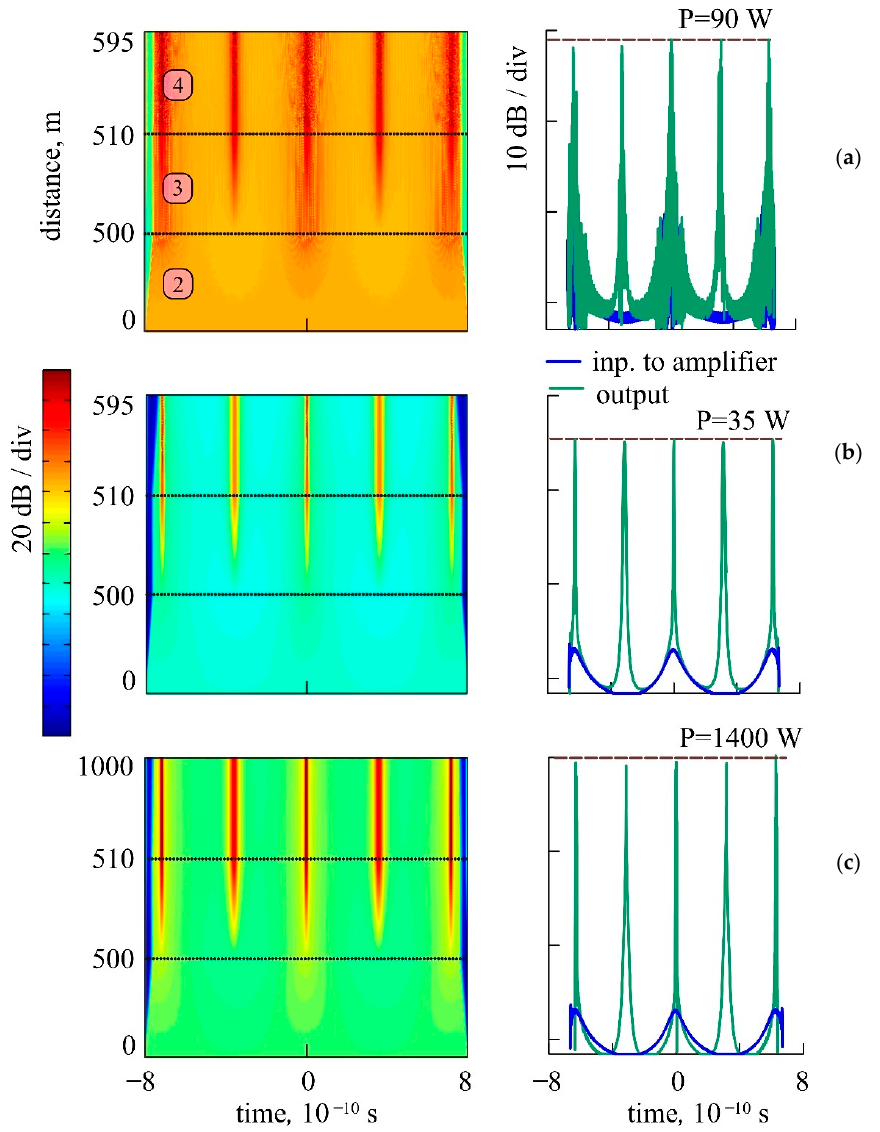
Figure 6. Evolution of time envelope profile in the fiber cascade (2–4) with different value of Kerr nonlinearity in a cascade 2–4: 0.1 ( a ), 10 − 4 ( W × m ) − 1 ( b , c ), and amplifier length of 10 m. (Right) Time profiles of pulse trains in semi-logarithmic scale at the amplifier input (blue curves) and output (green curves). Gain bandwidth is ∆ ω l = 10 12 s − 1 ( a – c ) at g ∼ 0.3 m − 1 , input power P 0 = 0.1 W ( a , b ), 1.0 W ( c ).